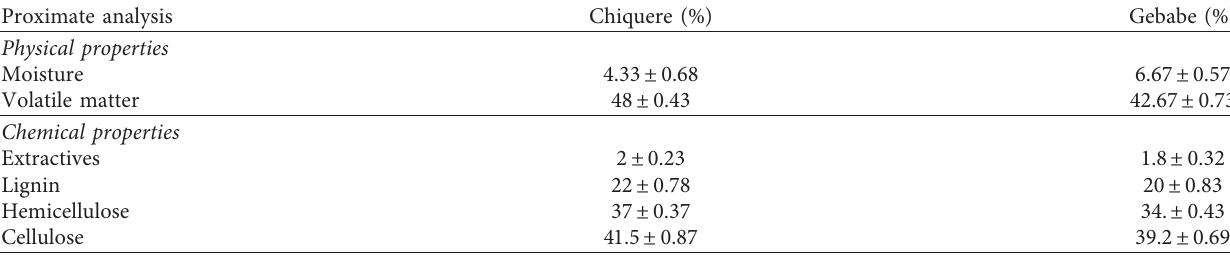
Table 1: Physical and chemical properties of Chiquere and Gebabe varieties of sweet sorghum.